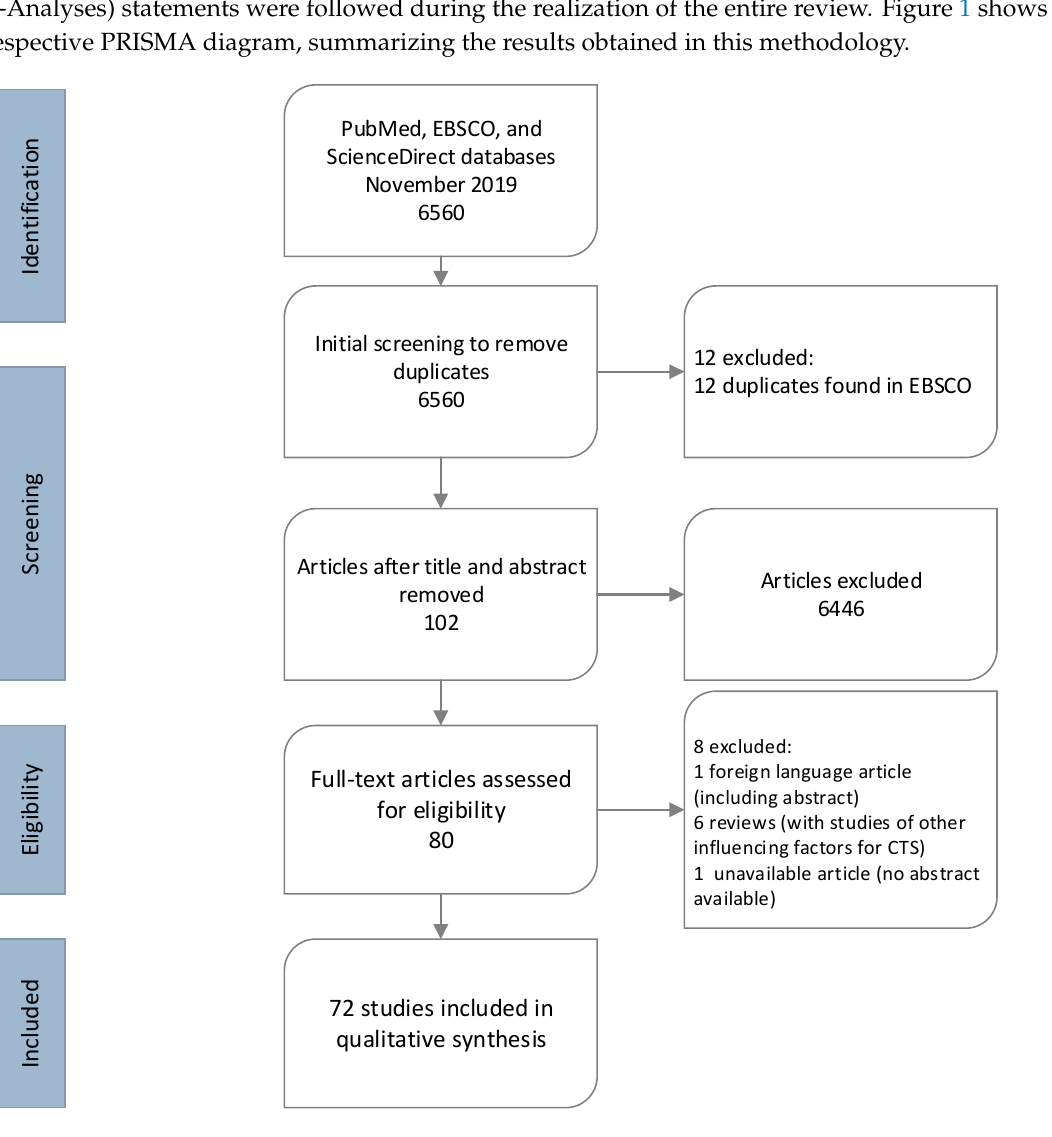
Figure 1. PRISMA (Preferred Reporting Items for Systematic Reviews and Meta-Analyses) flow diagram, adopted from Sousa E., V. R., Teixeira S., Seixas A., Mendes J., & Costa-Ferreim A. [8]. CTS: carpal tunnel syndrome.